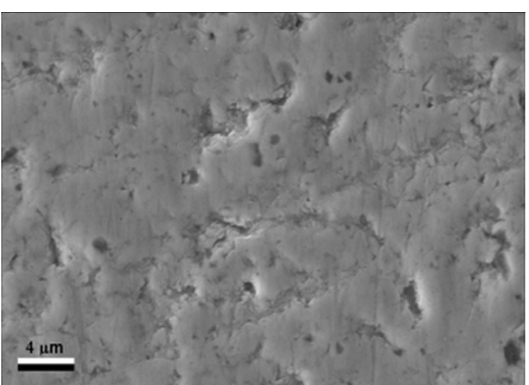
Figure 2. Surface SEM of the Base